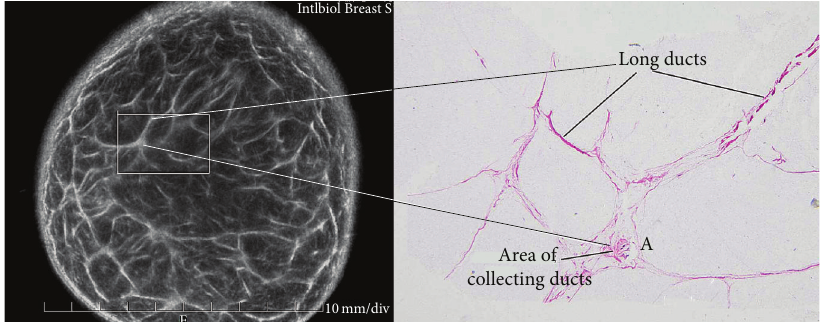
Figure 5: The tissue elements in the left reflection image (white) represent the supporting tissue of the breast ducts. These areas contain nerves, arteries, and ductal elements and are verified by histology (expanded image).